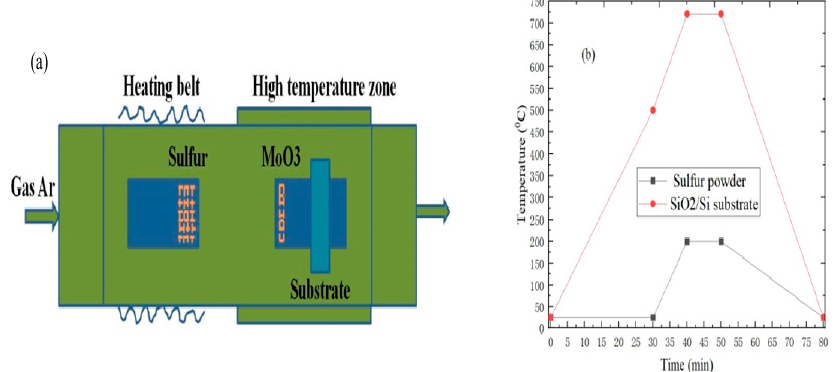
Figure 1. ( a ) Growth experiment schematic diagram of MoS 2 ; ( b ) temperature change diagram of MoS 2 grown by atmospheric pressure chemical vapor deposition (APCVD).